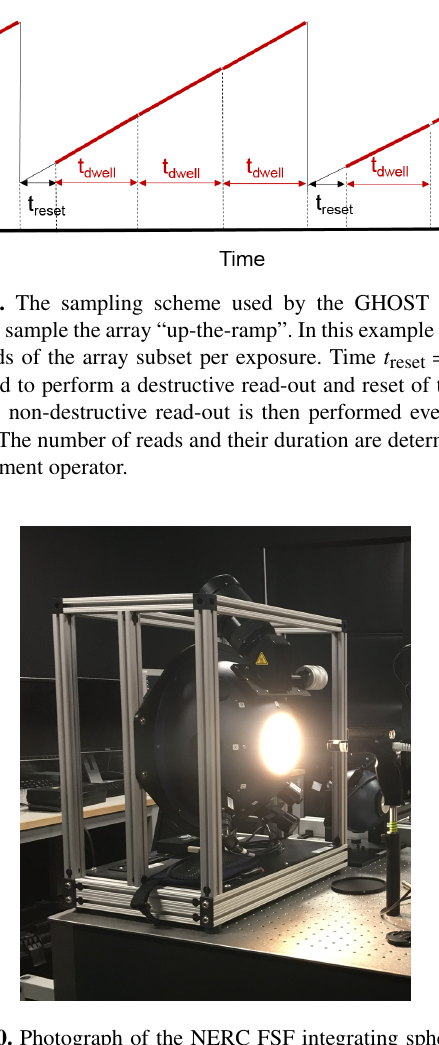
Figure 10. Photograph of the NERC FSF integrating sphere, with the 150W external lamp and variable aperture mechanism visible just above the output port (photograph by Chris MacLellan, NERC FSF).